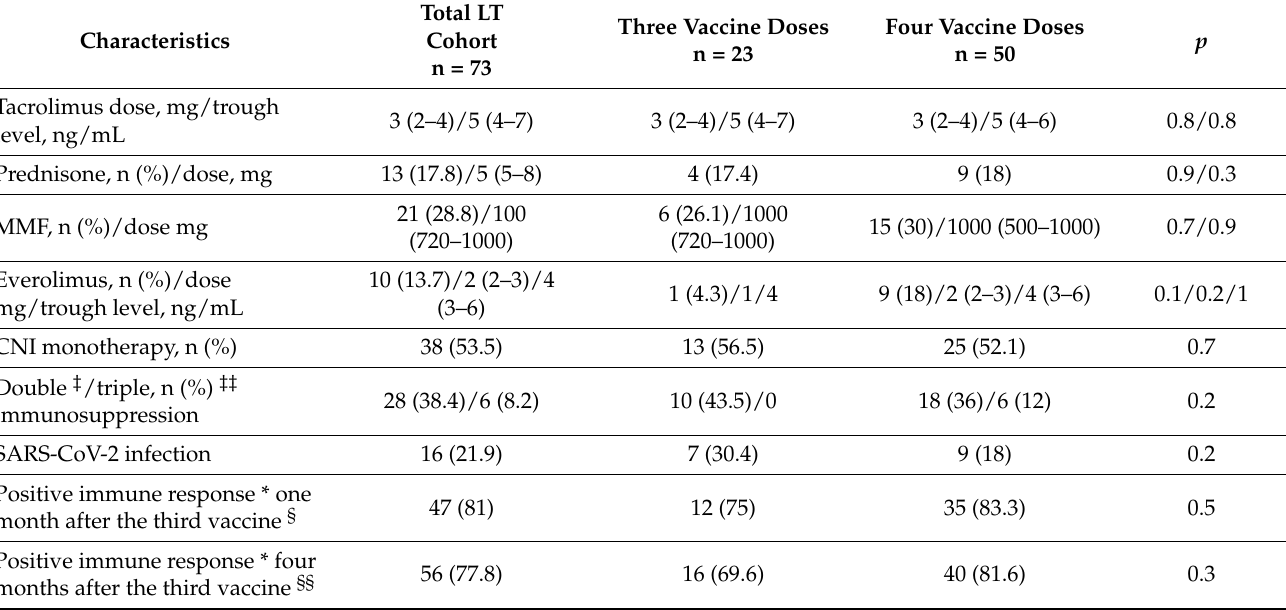
Table 2. Type of immunosuppression treatment and immune response of patients who received three vs. four doses of the BNT162b2 mRNA